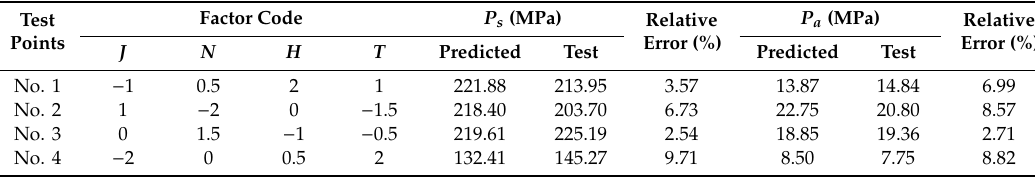
Table 7. Results of verification tests and their relative error